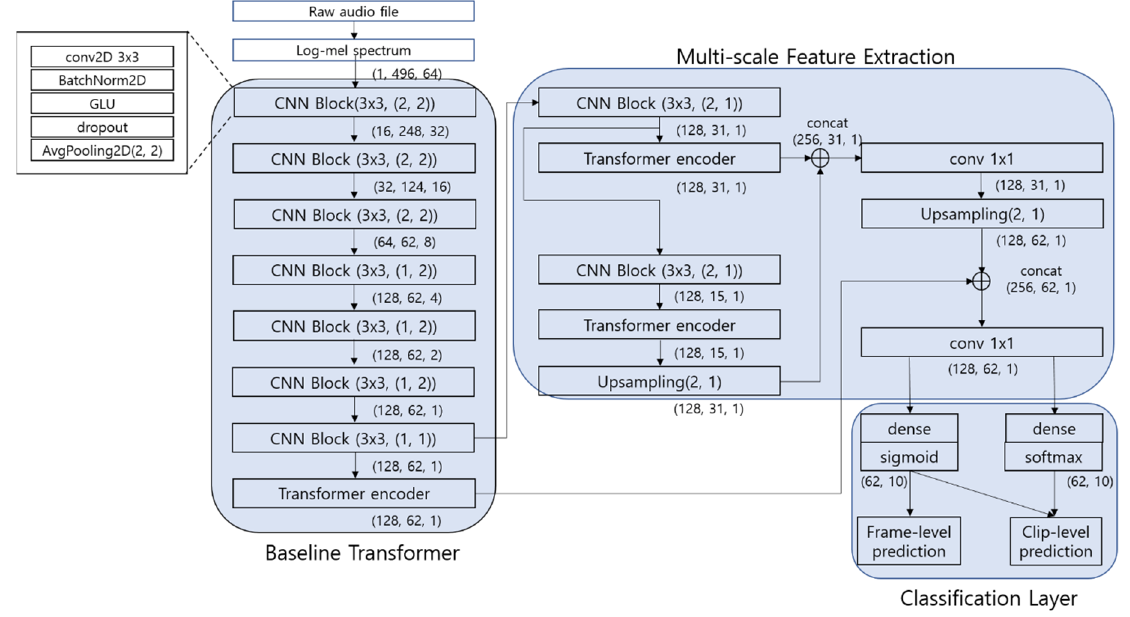
Figure 2. Proposed Transformer Network Model .